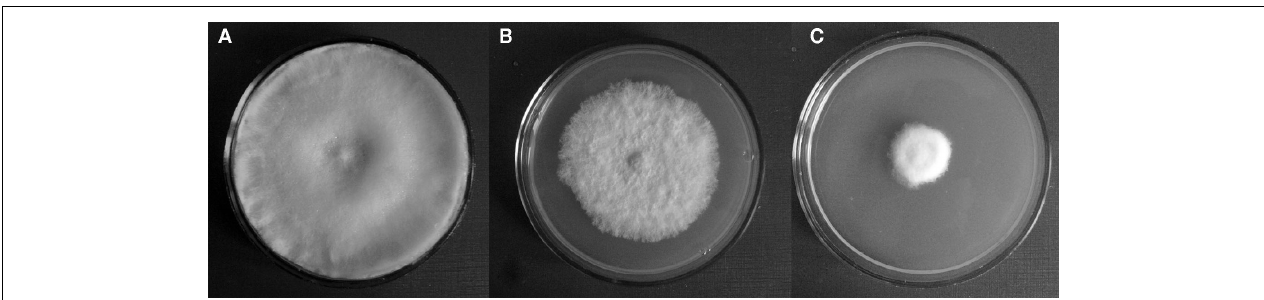
FIGURE 5 |Ten-day growth of colonies of F. culmorum cultured in the presence of: (A) 4-Hydroxybenzaldehyde (4-HBA), 200ppm; (B) Folicur, 0.5ppm; and (C) Folicur, 0.5ppm, with 4-HBA, 200ppm.